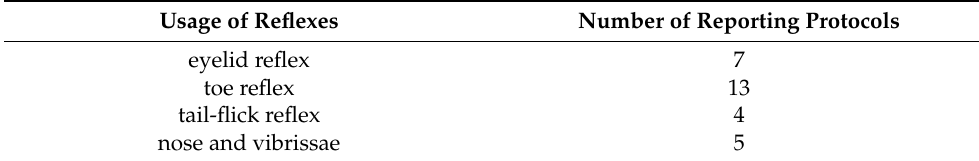
Table 2. Reported methods for assessment of anesthesia depth. Usage of Reflexes